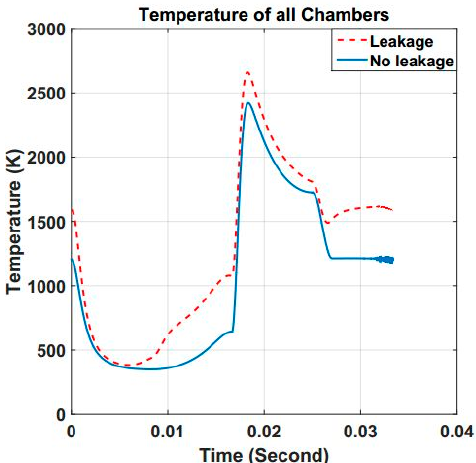
Figure 13. Temperature of working fluid vs. time over one cycle (30 Hz).